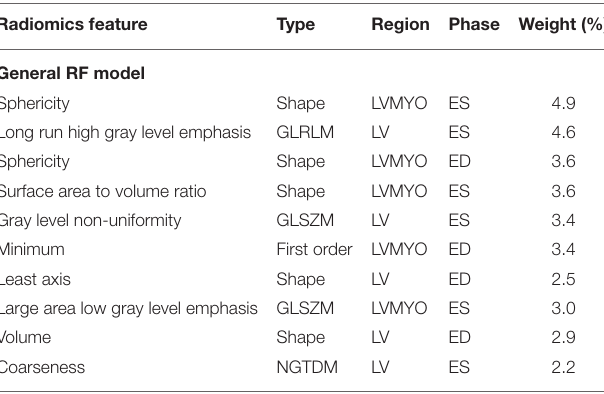
FIGURE 4 | Differential diagnosis overlapping radar plot, comparing the distribution of the selected radiomics across types of